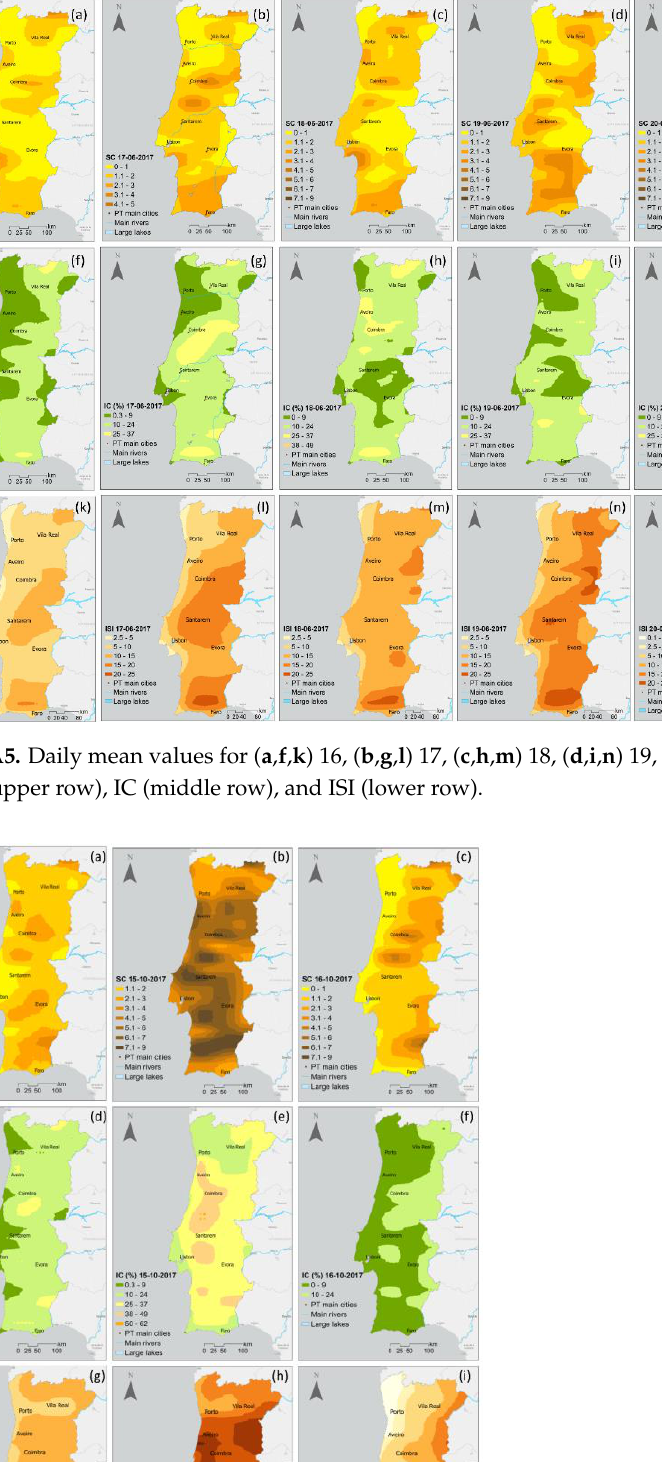
Figure A6. Daily mean values for ( a , d , g ) 14, ( b , e , h ) 15, and ( c , f , i ) 16 October 2017, for SC (upper row), IC (middle row), and ISI (lower row).